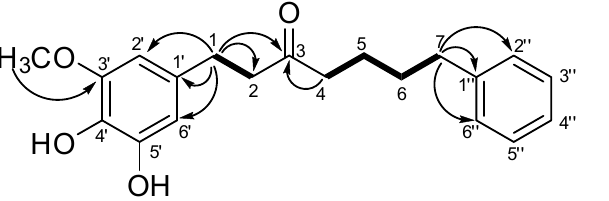
Figure 3. Key 1 H- 1 H COSY (bold) and HMBC (arrows) correlations for compound 4 .